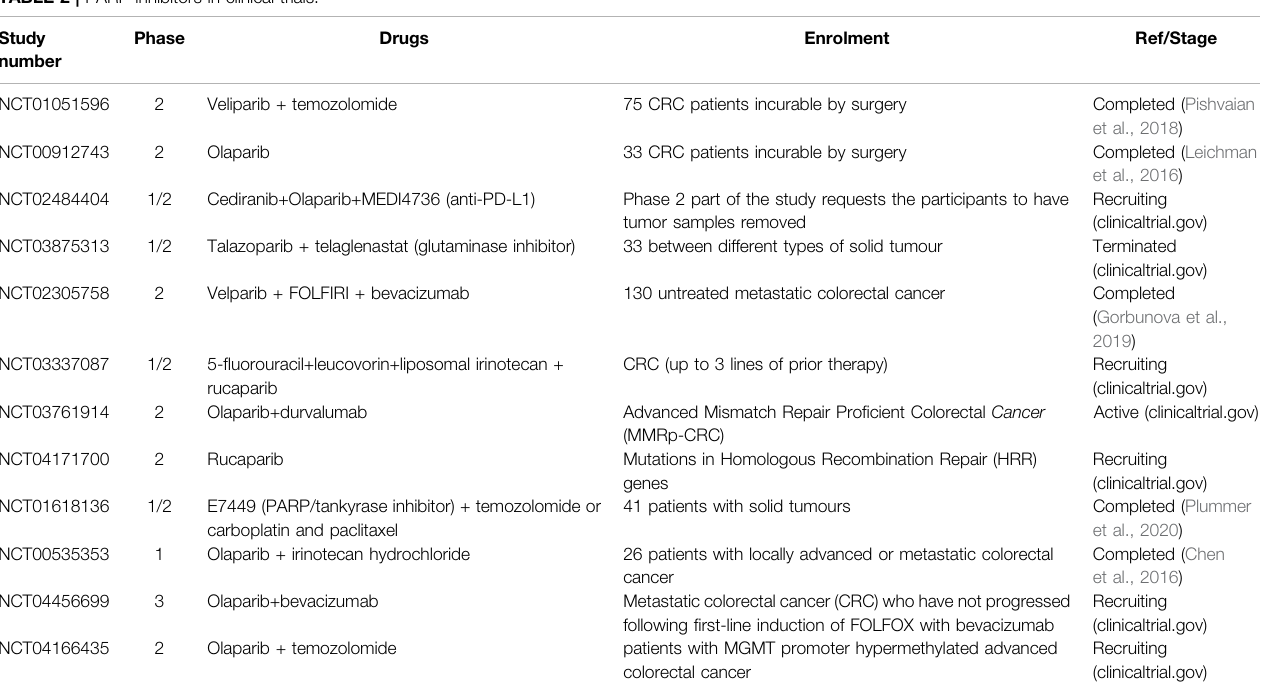
TABLE 2 | PARP inhibitors in clinical